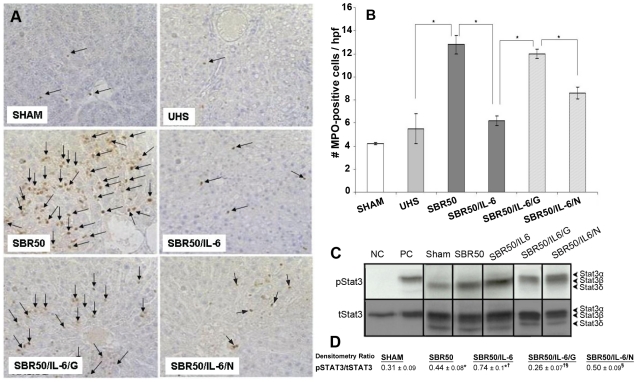
Effect of resuscitation, IL-6 treatment and GQ-ODN pre-treatment on T/HS-induced liver inflammation and Stat3 activation.Rats were subjected to sham protocol (Sham, n = 3), unresuscitated T/HS (UHS, n = 3), T/HS treated with placebo at the beginning of resuscitation (SBR50, n = 4), T/HS treated with IL-6 at the beginning of resuscitation (SBR50/IL-6, n = 4), T/HS preceded by treatment with GQ-oligodeoxynucleotide (GQ-ODN) 24 hours prior to resuscitation with IL-6 (SBR50/IL-6/G, n = 3), or T/HS preceded by treatment with nonspecific-ODN (NS-ODN) 24 hours prior to resuscitation with IL-6 (SBR50/IL-6N, n = 3). The livers were harvested 60 minutes after the start of resuscitation. MPO staining was performed in paraformaldehyde-fixed livers. Representative photomicrographs of 1000x fields of liver specimens from each experimental group are shown (2A). Arrows indicate MPO-positive cells. In Figure 2B, MPO-positive cells were counted in 20 hpf; data presented are the means ± SEM of each group (n≥5). Bars marked with an asterisk (*) differ significantly within the pair (p<0.05). Figure 2C shows representative immunoblots of protein extracts of whole liver from each group, a negative control (NC) cells and positive control (PC) cells developed with monoclonal antibodies to either phosphorylated (p)Stat3 and total (t)Stat3. Bands representing Stat3α, Stat3β, and Stat3δ isoforms are indicated on the right. Heavy lines separate representative samples from individual gels. Figure 2D shows the mean densitometric ratio of (p)Stat3 to (t)Stat3 bands ± standard deviation of the groups (n≥3 for each). Statistically significant (p<0.05) intergroup comparisons are indicated by “*”, “†”, and “§”, respectively.